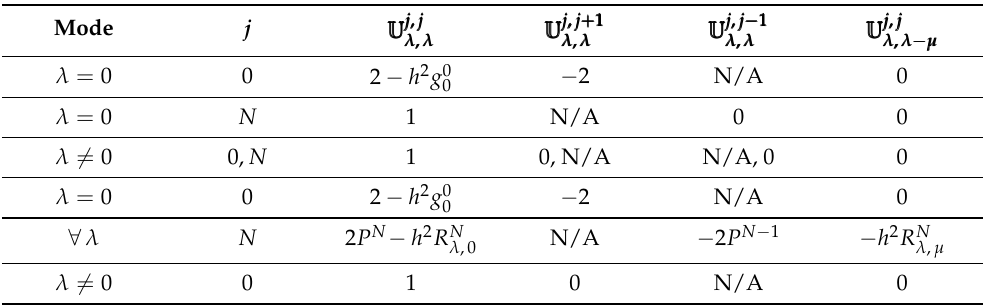
Table 4. Non-vanishing matrix elements of matrix U that define DBC (shown above) and NBC (shown below) for a disc. N/A specifies those elements that lay outside U